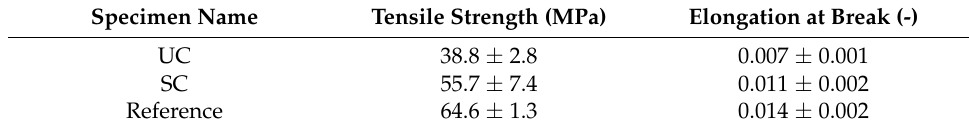
Table 14. Average tensile strengths and elongations at break of the internal pressure tests of samples with (SC) and without (UC) glass fiber sizing and reference samples.